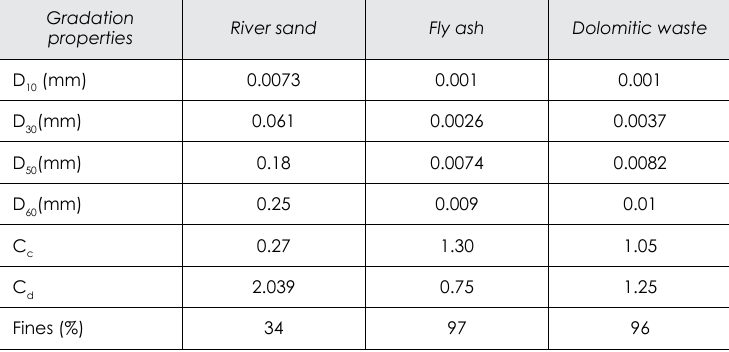
Figure 2: Particle size analysis of RS, FA and DW The modulus properties of the RS and the tested waste materials were determined from the particle size distribution (PSD) curve shown in Figure 2. The major textural properties of brick material ( i.e. the per cent fines; >0.425 mm), the particle sizes that permit 10%, 30%, 50% and 60% of the granular brick materials, the coefficient of uniformity (C d ), and the coefficient of curvature (C c ) are presented in Table 3. Table 3: Gradation properties of bricks materials Gradation properties River sand Fly ash Dolomitic waste